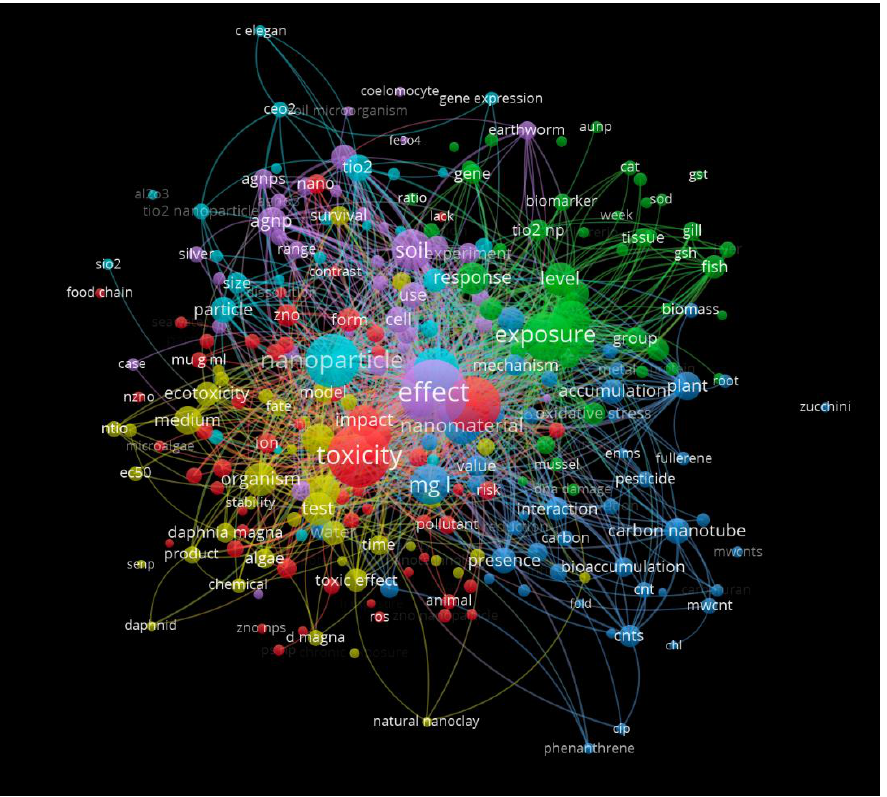
Figure 8. Map obtained by searching for keywords using the VOSviewer software 1.6.18 and selecting 303 articles.